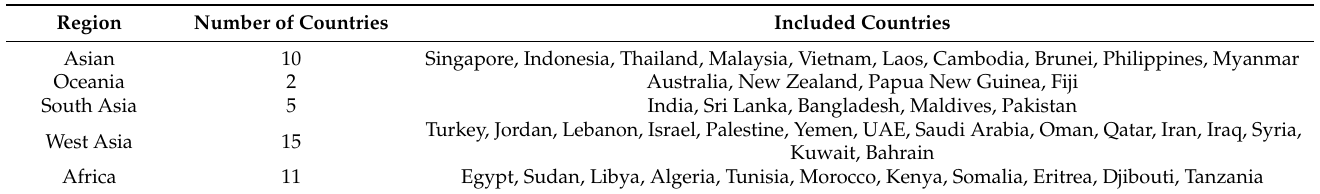
Table 1. Countries along the